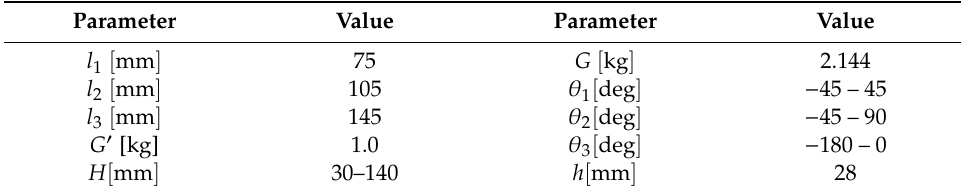
Table 3. Structural parameters of the robot.